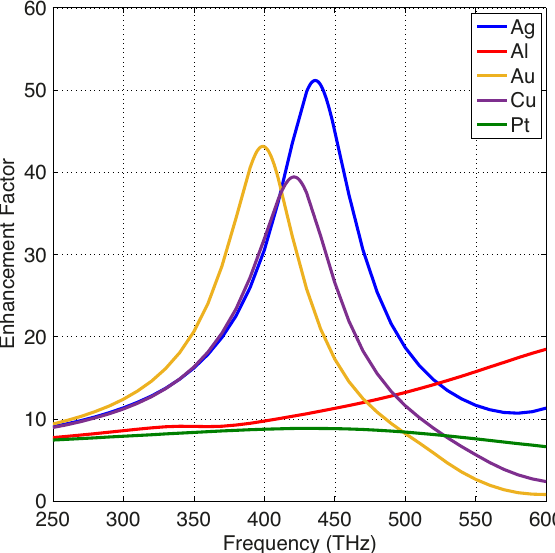
Figure 4: Power enhancement factor at the gap of an bowtie nanoantenna when different materials are